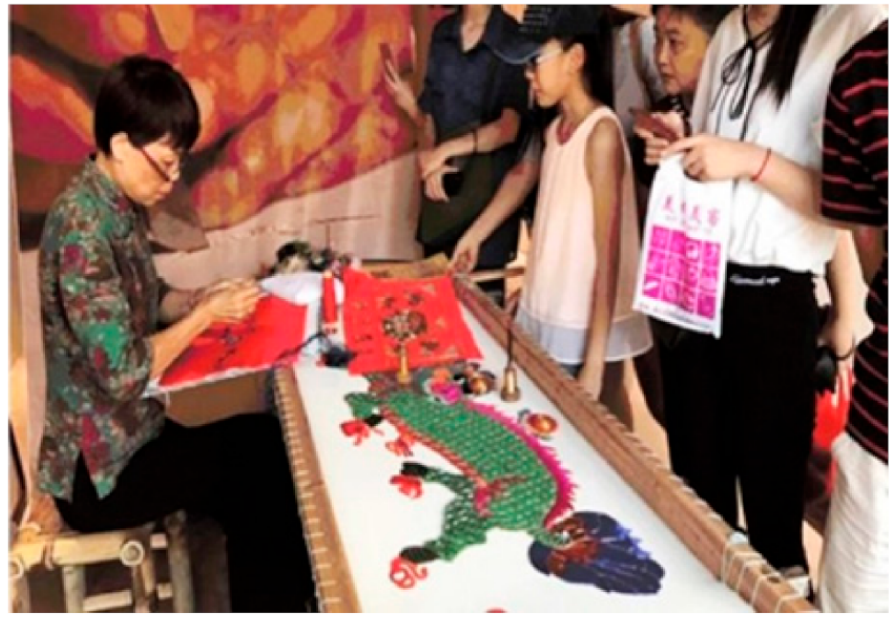
Figure 2. The inheritor of Jincang embroidery carried forward her craft through the